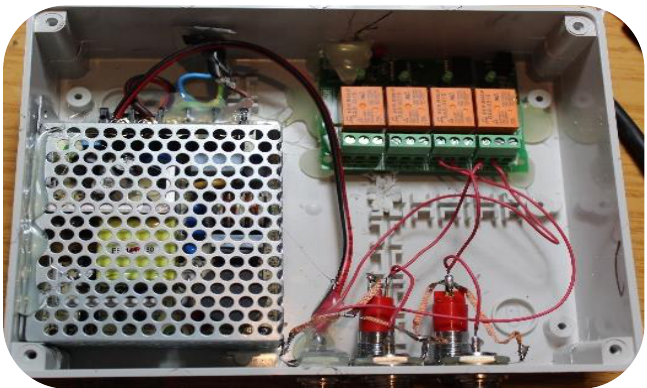
Figure 11. Automatic control switch that interfaces with the 90° hybrid.